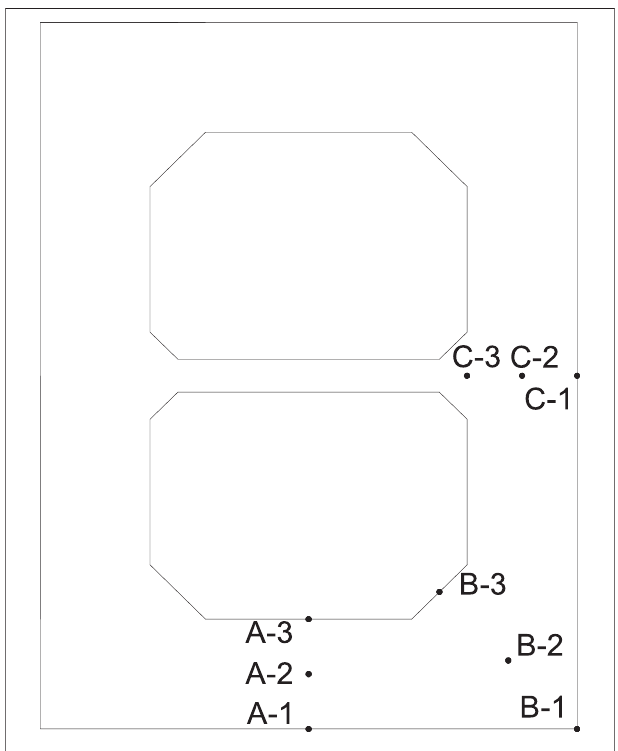
FIGURE 12 | The locations of the measuring